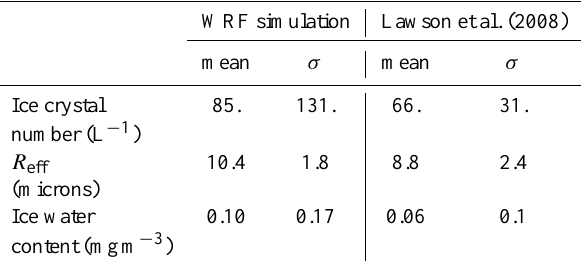
Table 2. Bulk microphysical properties (ice water content, ice crys- tal number and effective radius, R eff ) of the simulated cirrus clouds at 15.5km on January 28, at 10:00 and values reported from aircraft observations (Lawson et al.,